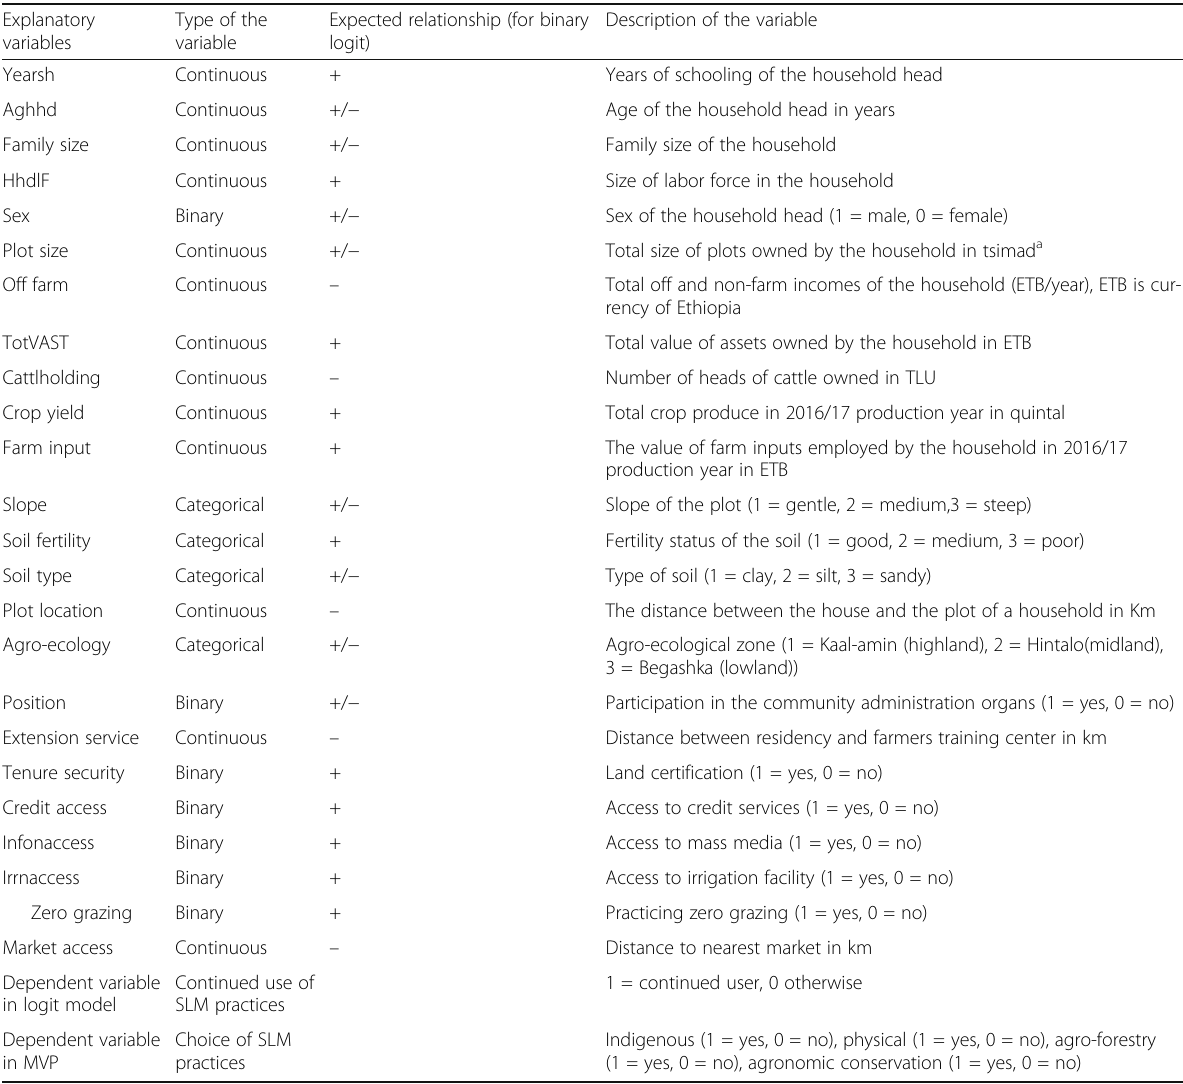
Table 3 Description of explanatory variables included in the binary logit and MVP models Explanatory